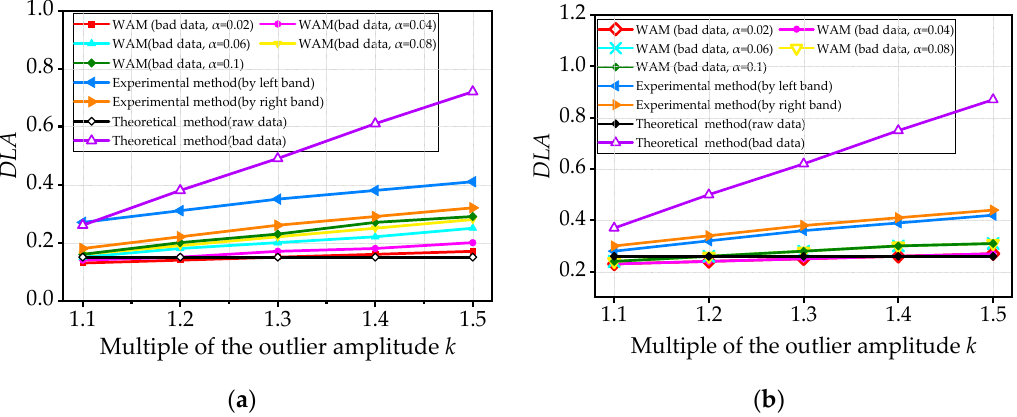
Figure 17. Comparison of DLA with different data. ( a ) DLAs for two-span continuous girder bridge; ( b ) DLAs for three-span continuous girder bridge.